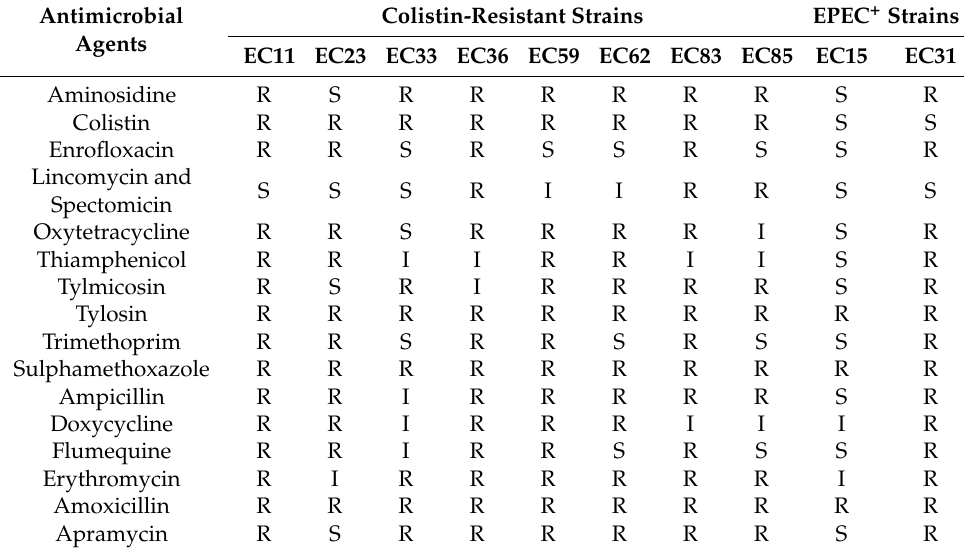
Table 2. Antibiotic resistance pattern of clostin-resistant and EPEC + E. coli